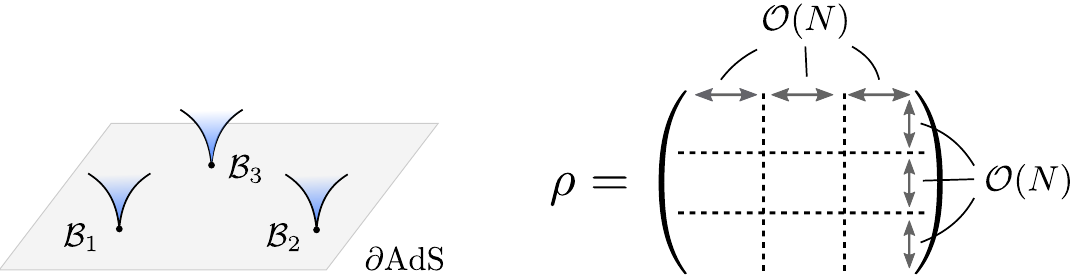
Figure 40 . The three-point function of the bubbling geometries and the corresponding (cid:26) (cid:12)eld. Each operator insertion modi(cid:12)es the geometry near the AdS boundary. The full geometry is expected to be a nontrivial connected geometry connecting three asymptotic regions. The (cid:26) (cid:12)eld is now a huge matrix with a block structure where each block is of O ( N ). We expect that there is a relation among the expectation value of the o(cid:11)-diagonal block, the correlation between two operators and the connectedness of the dual